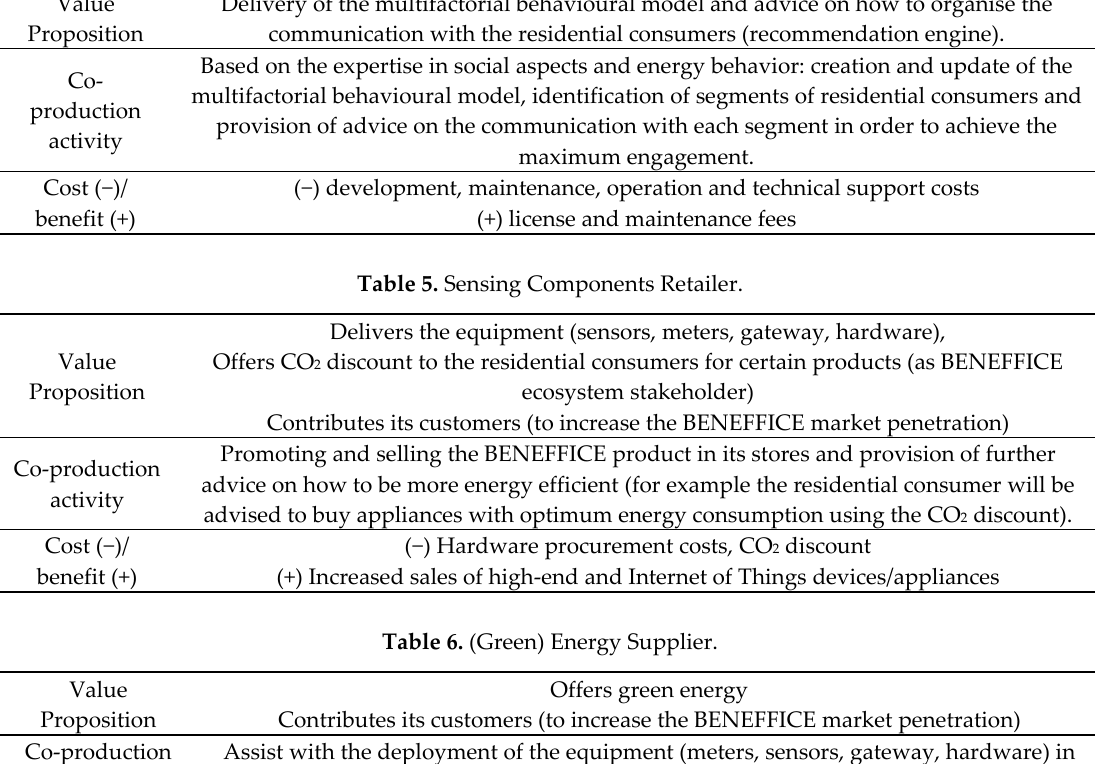
Table 4. Behavioural Model Supplier.